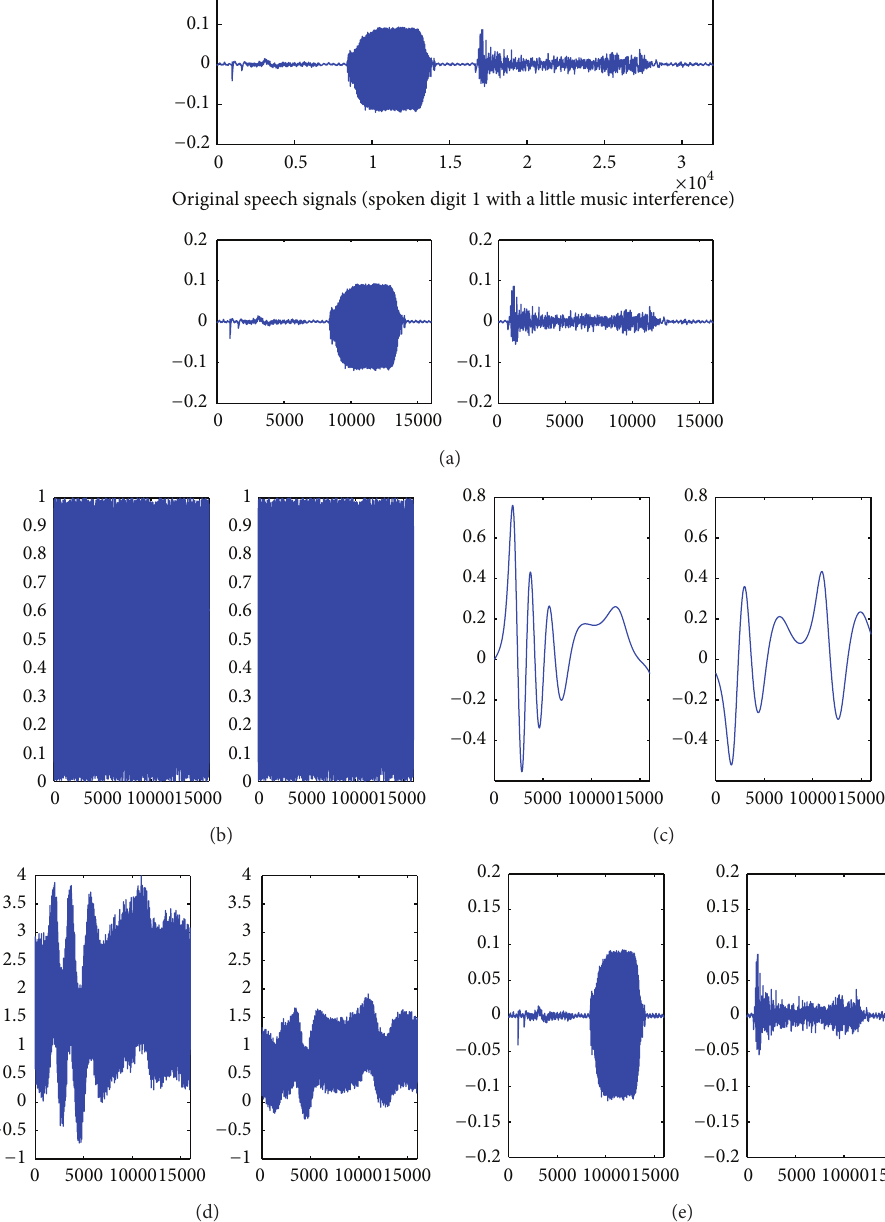
Figure 2: (a) The original speech signals and two segments 𝑠 1 (𝑡) , 𝑠 2 (𝑡) ; (b) two segments of key signals I 𝑘 1 (𝑡) , 𝑘 2 (𝑡) ; (c) two segments of key signals II ℎ 1 (𝑡) , ℎ 2 (𝑡) ; (d) two encrypted segments 𝑥 1 (𝑡) , 𝑥 2 (𝑡) ; (e) two recovered segments by approximate calculation ̂𝑠 1 (𝑡) , ̂𝑠 2 (𝑡) .